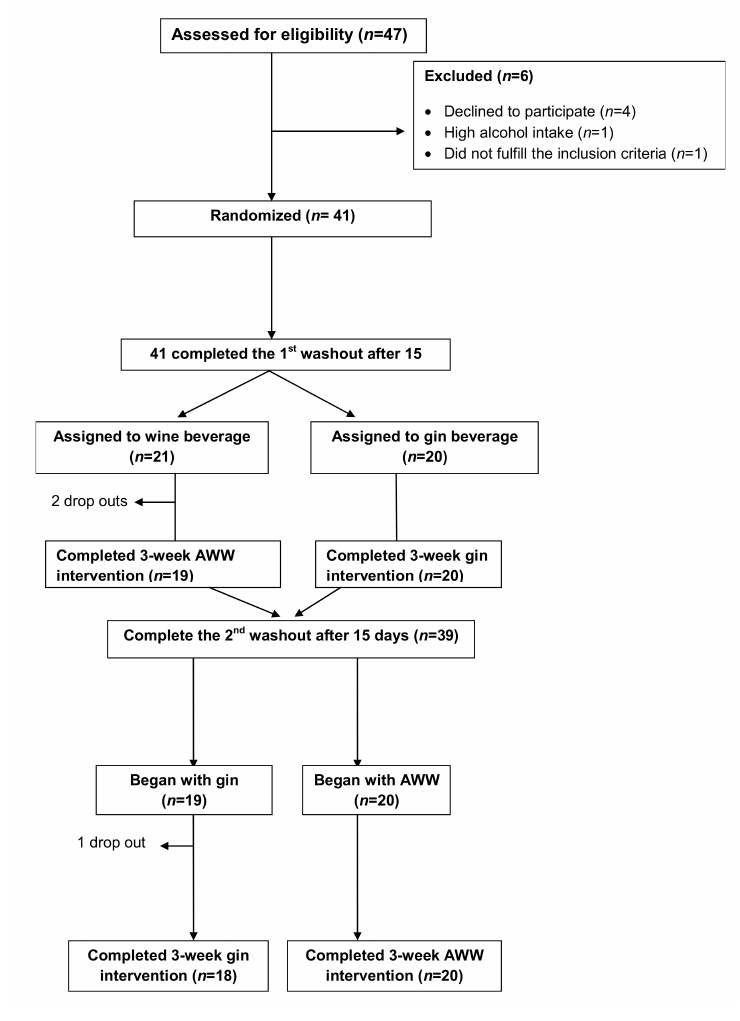
Figure 1. Flowchart. Table 2. Baseline characteristics of the 38 study